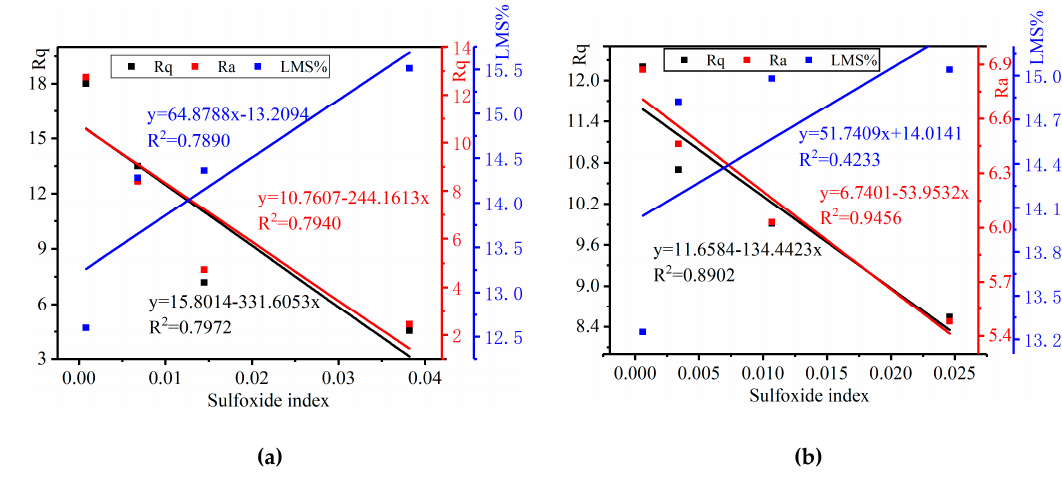
Figure 16. Relationship between the sulfoxide index, LMS%, and AFM index. ( a ) Base mastics; ( b ) SBS-modified mastics.